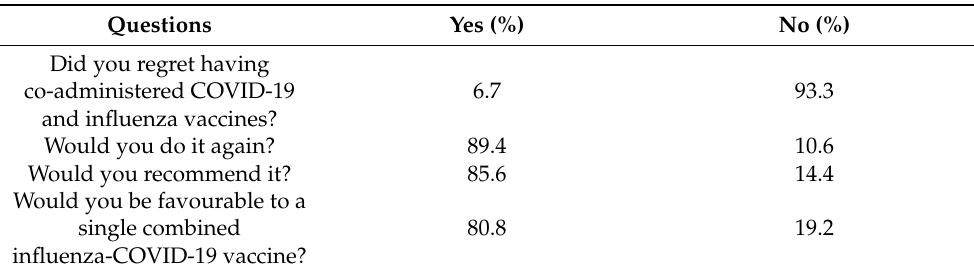
Table 2. Personal opinions about co-administration in the COVID-19 and influenza vaccines group. Size sample: 64 HCWs. Response percentage: